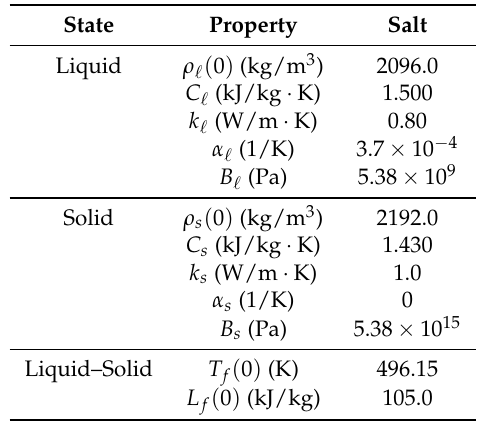
Table 1. Thermodynamic data for the nitrite salt KNO 3 /NaNO 3 at 1atm